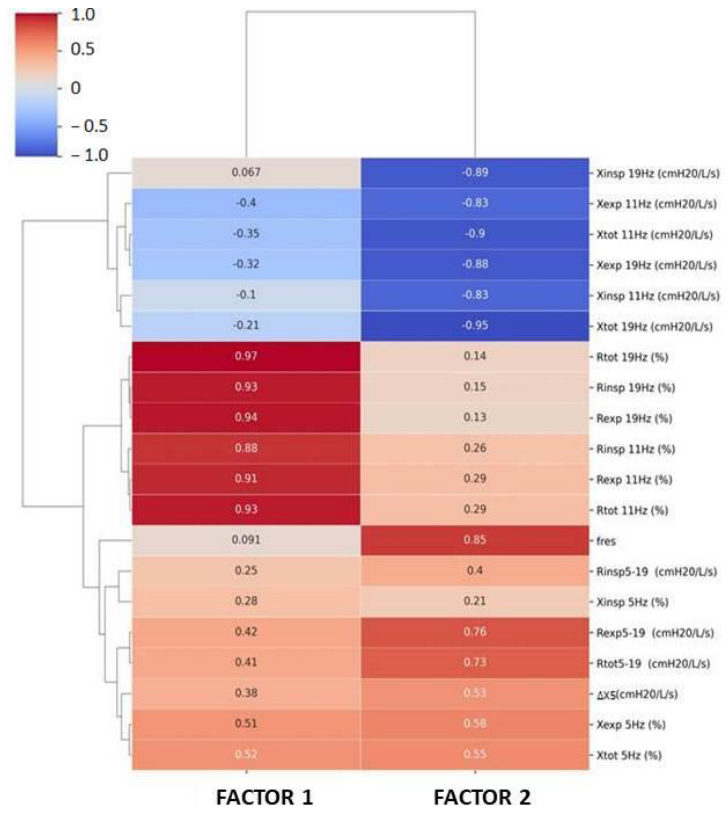
Figure 3. Factor loads obtained by factor analysis of baseline FOT measurements in IIP patients based on the order of hierarchical clustering. R, resistance; X, reactance; insp, inspiratory; exp, expiratory; tot, total; ∆X5, expiratory flow limitation; Fres, resonant frequency.